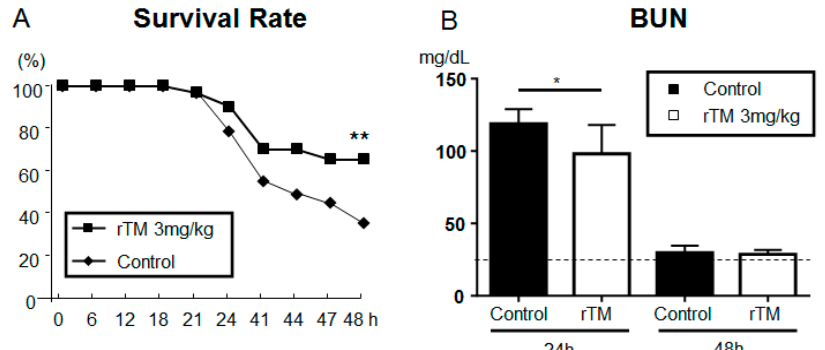
Figure 2. Effect of recombinant human soluble thrombomodulin (rTM) on the survival and blood urea nitrogen (BUN) level in the development of acute kidney injury after lipopolysaccharide (LPS) injection. ( A ) Survival of control and rTM-treated mice subjected to sepsis by LPS-injection. Mice were evaluated until 48 h after LPS-injection (control, n = 20; rTM, n = 20; ** p < 0.01 ). ( B ) Renal function of control and rTM-treated mice at 0 (control, n = 5; rTM, n = 5), 24 (control, n = 18; rTM, n = 16), and 48 h (control, n = 8; rTM, n = 12; ** p < 0.01 ) before and after LPS-injection, assessed by BUN levels. The data are the mean values ± standard error of the mean (* p < 0.05 , control versus rTM-treated mice). Dotted lines represent mean values from saline-treated mice without LPS.